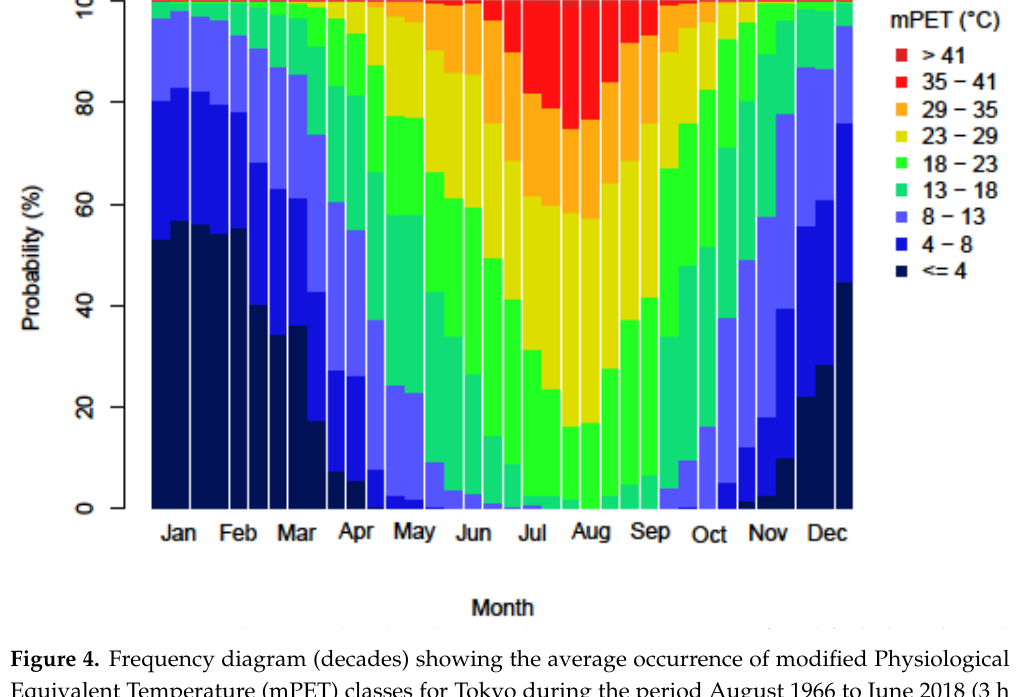
Figure 3. Frequency diagram (decades) showing the average occurrence of Physiologically Equivalent Temperature (PET) classes for Tokyo during the period August 1966 to June 2018 (3 h classes, PET calculates much higher frequencies for the class >41 ◦ C (up to 3.9% for 24th of July) than resolution). The reference height for the results is 1.1 m. The sensation classes are defined in Table 2. mPET (with a maximum of 1.8% for the 1st of August).